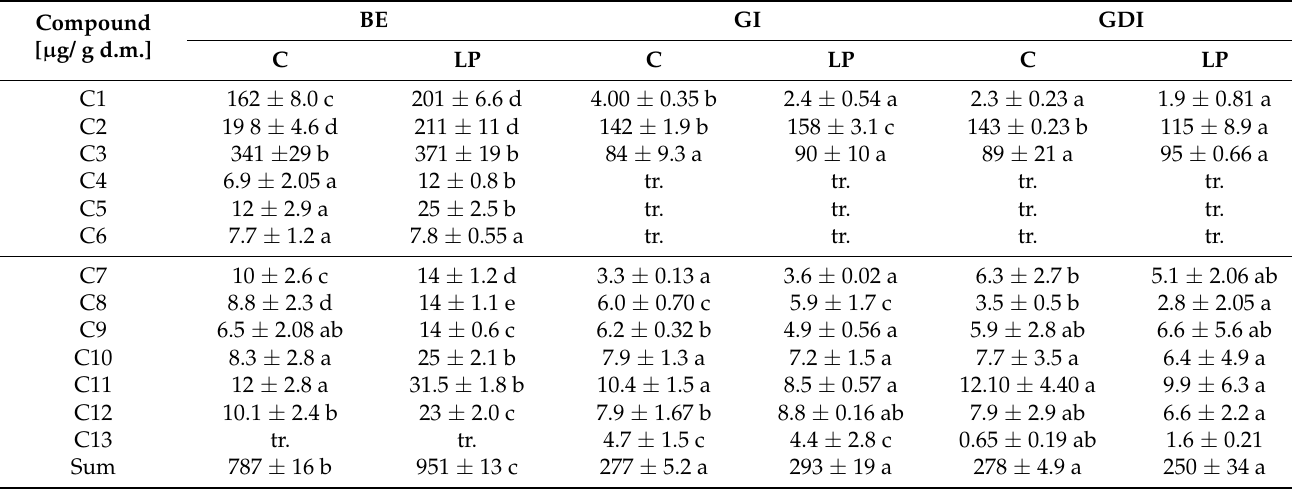
Table 2. Qualitative and quantitative analysis of phenolics from the fresh control and probiotic-rich sprouts. Compound [ µ g/ g